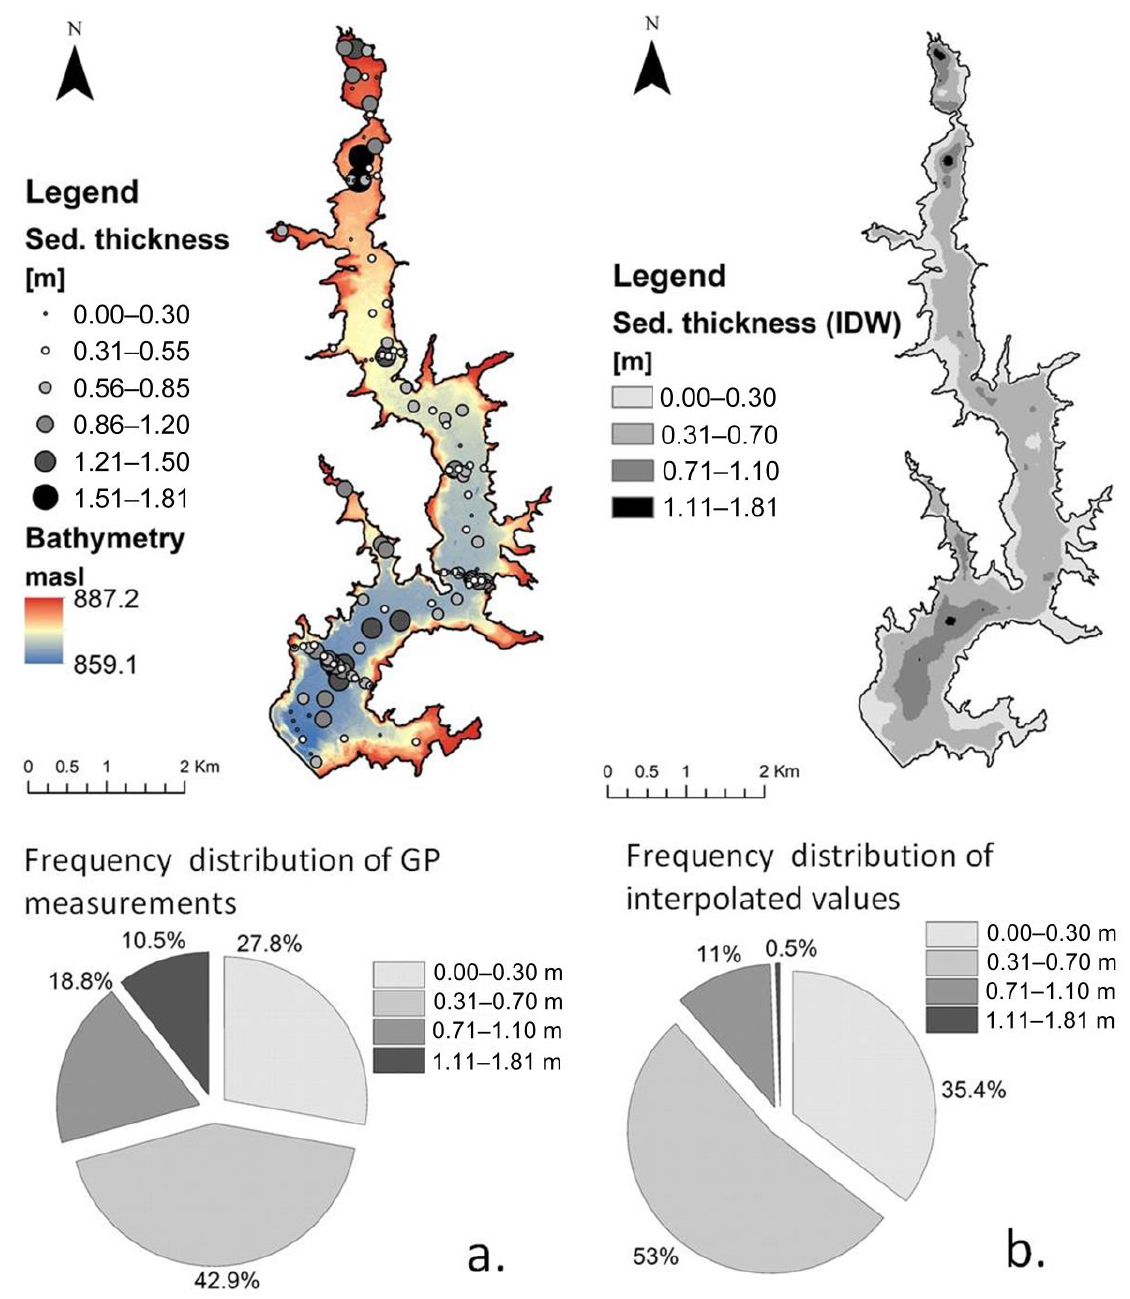
Figure 21. ( a ) Locations of GP measurement and the visualization of the measured value. The pie chart shows the frequency distribution of the measured values of sediment magnitude ( b ) . The interpolated map of sediment thickness based on the GP measurements with distribution frequency of the interpolated values. Adapted from [12].